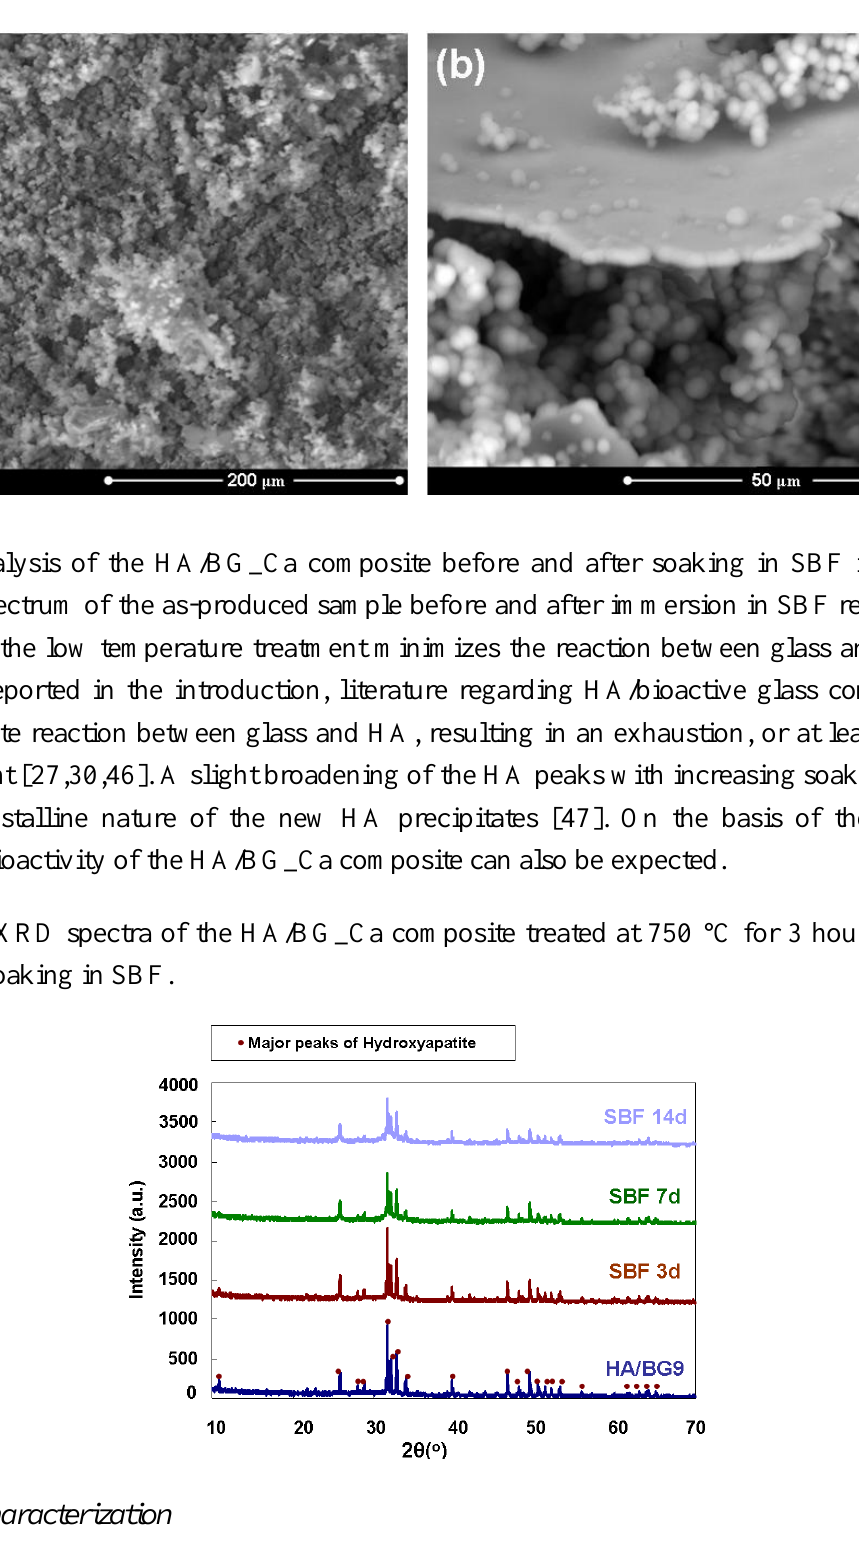
Figure 6. (a) Micrograph of the surface of a HA/BG_Ca sample (treated at 750 °C for 3 hours) after 14 days in SBF; (b) detail of the precipitated hydroxyapatite on the sample surface.